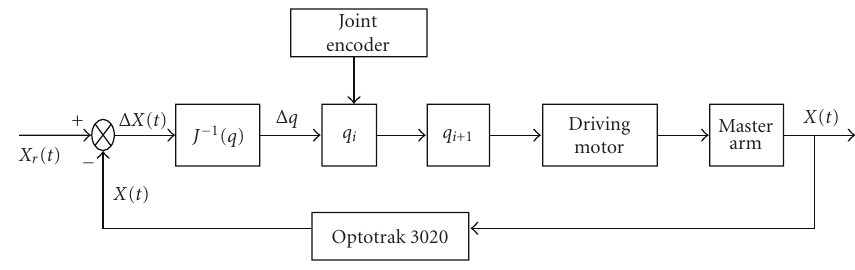
Figure 4: RMRC control